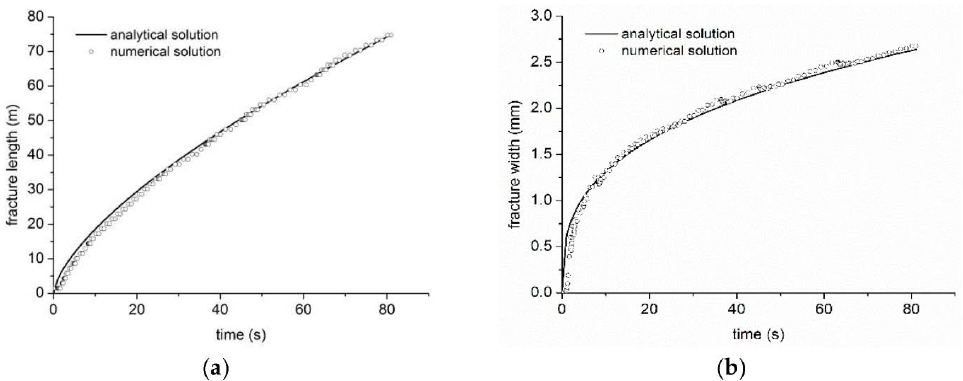
Figure 3. Numerical solution and analytical solution of hydraulic fracturing: ( a ) fracture length and ( b ) fracture width.